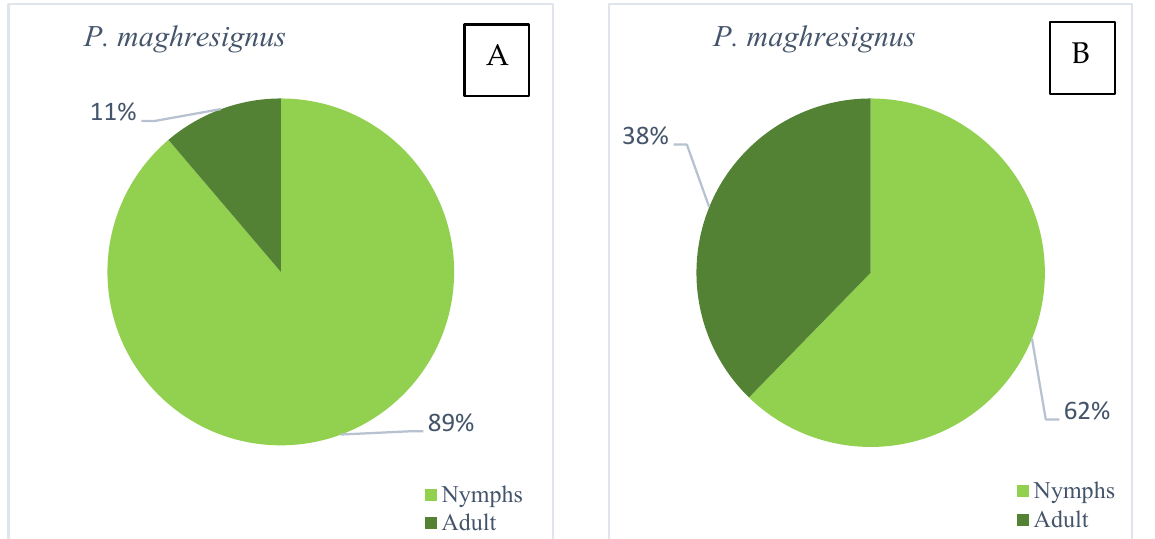
Figure 6. P. maghresignus nymphs and adults collected on Asphodelus microcarpus ; ( A ), early April and ( B ), late April, Feija (Jendouba) 2021.